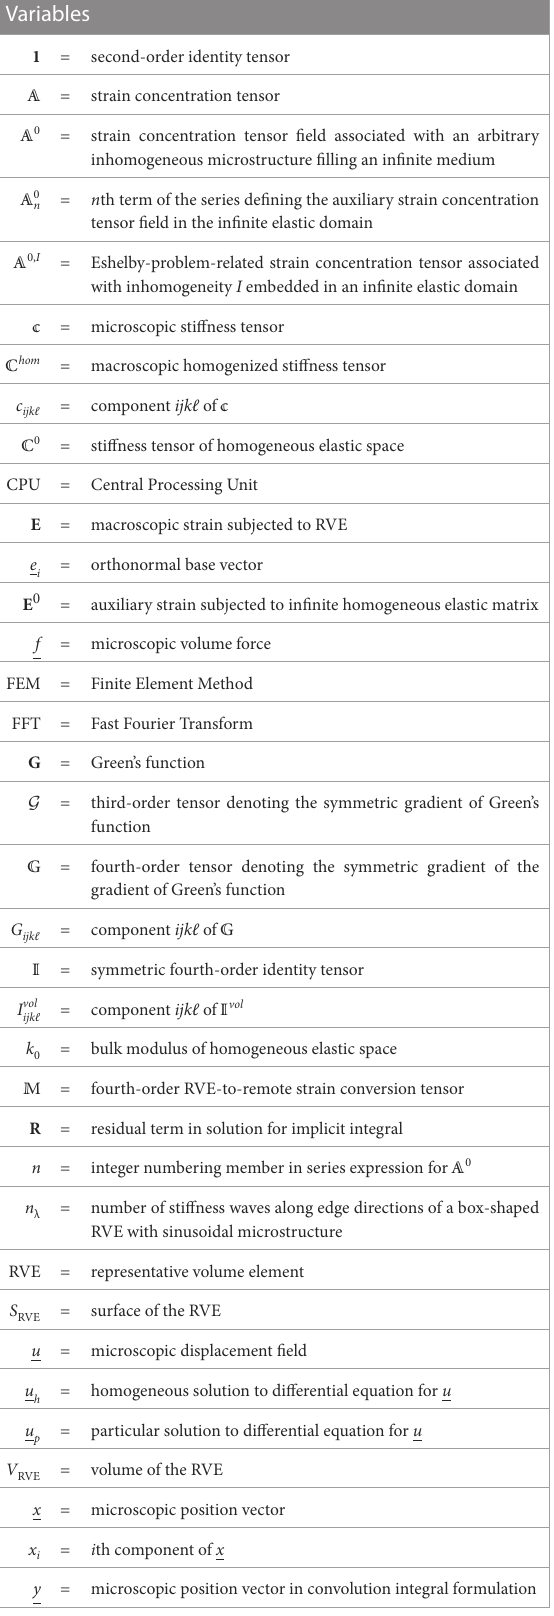
TABLE1 Mathematicalsymbolsandabbreviations.